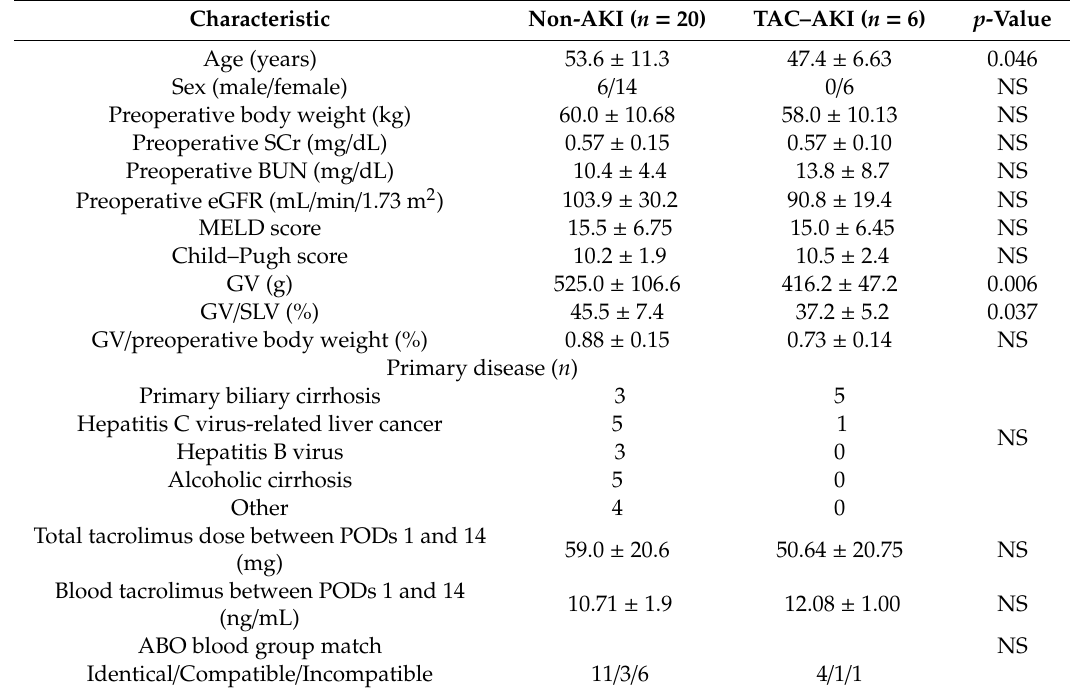
Table 1. Patient